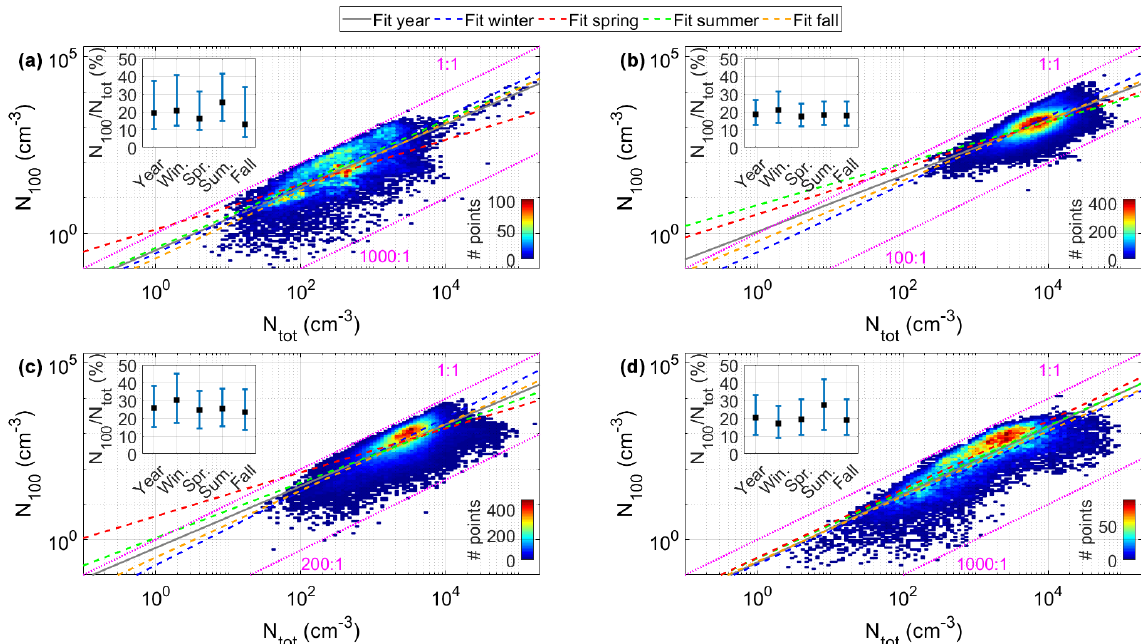
Figure 13. Scatter plots of N 100 as a function of N tot (hourly averages) for the different station types: (a) polar sites, (b) urban sites, (c) other lowland sites and (d) mountain sites. The colour of each pixel indicates the number of data points (hourly averages) falling into its area (all pixels have equal area on a log–log scale). The linear fit performed on the logarithm of the data, separately for each period (year and seasons), is also presented. The statistics of the ratio between N 100 and N tot calculated for each of these periods are in addition shown for each station type in the insert of the corresponding panel; the markers represent the median of the ratios, and the lower and upper limits of the error bars indicate the first and third quartiles,